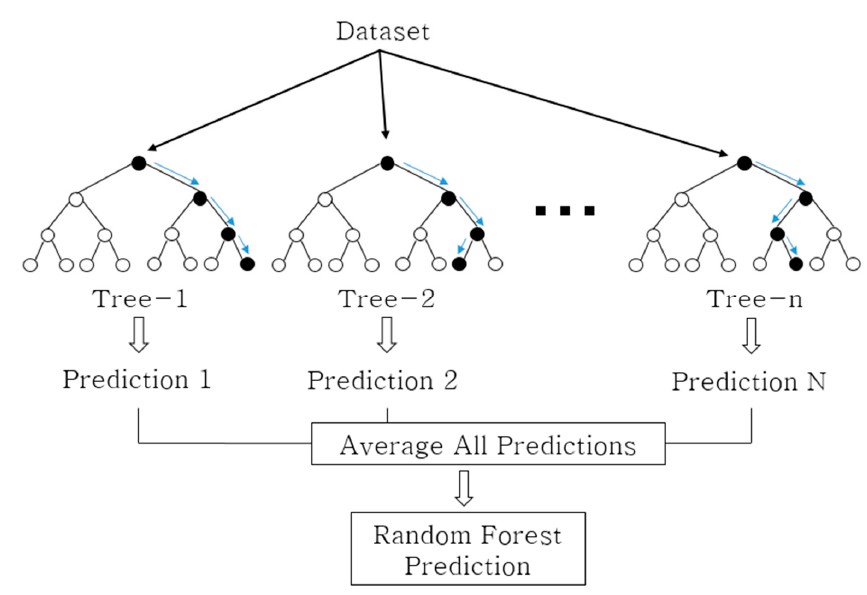
Figure 2. Schematic diagram of the random forest algorithm.